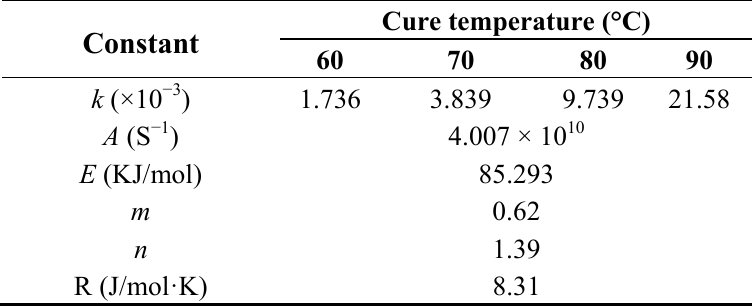
Table 1. Constant of cure kinetics for silicone.